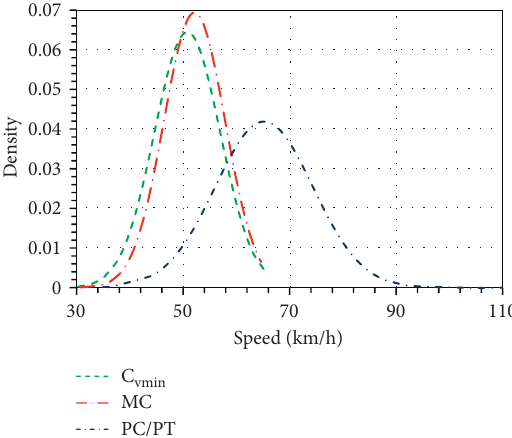
Figure 3: Normal probability distribution plots for